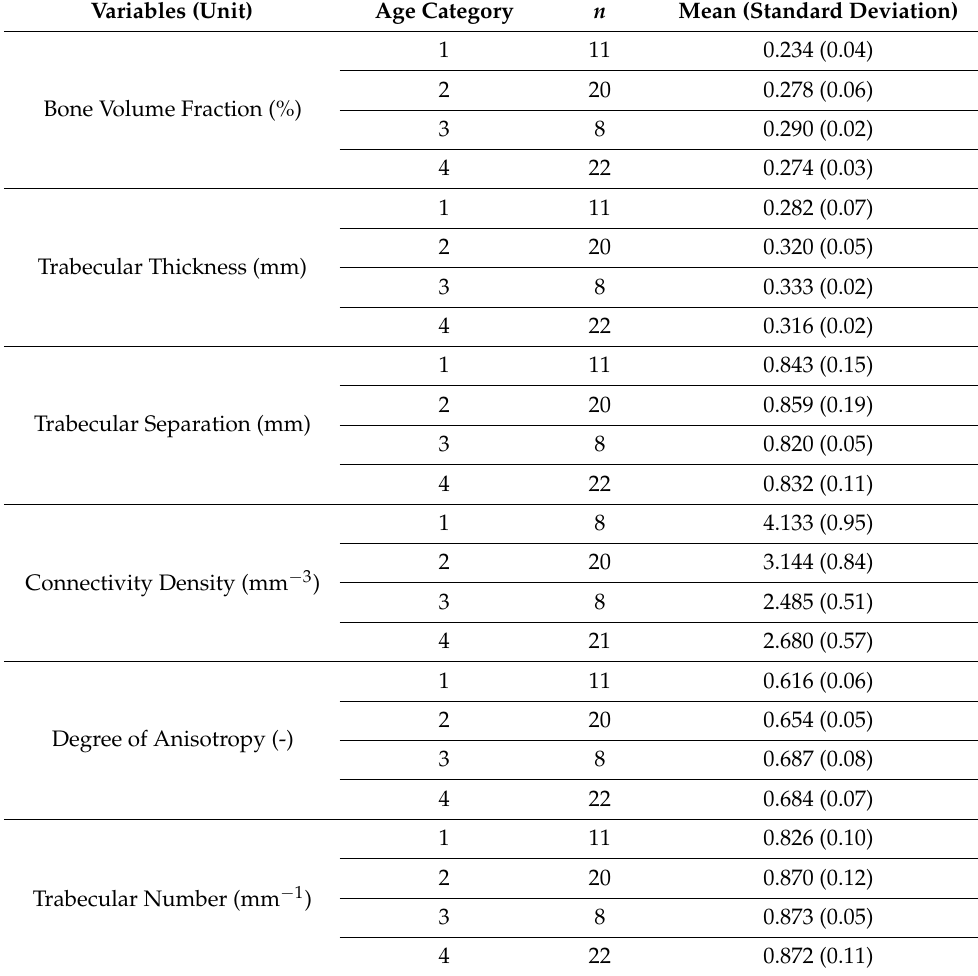
Table 3. Mean statistics for all variables by age category. Note: body mass is sex-pooled, while the other parameters are region-pooled (i.e., both